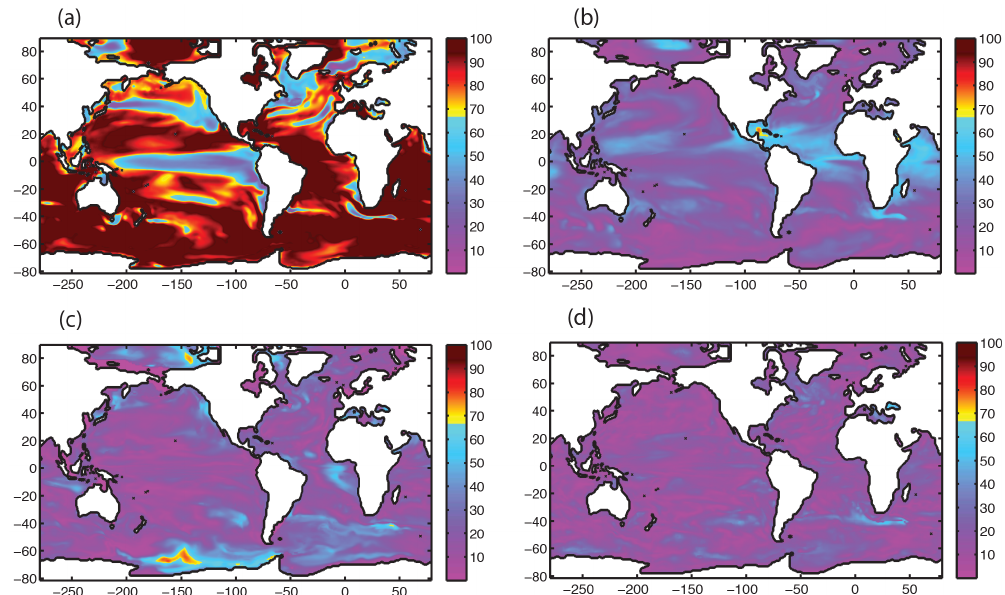
Figure 5. The confidence intervals for emergence of each of the drivers for the time period 2005–2014, using a 10-year window for calculating trends. The analysis here is otherwise identical to that shown in Fig. 2, except that there a 30-year window was chosen. The panels show the distributions for (a) (cid:127) arag , (b) SST, (c) O 2 inventories, and (d) NPP. This analysis reveals significantly lower confidence intervals for the 10-year window than for the 30-year window for each of the four